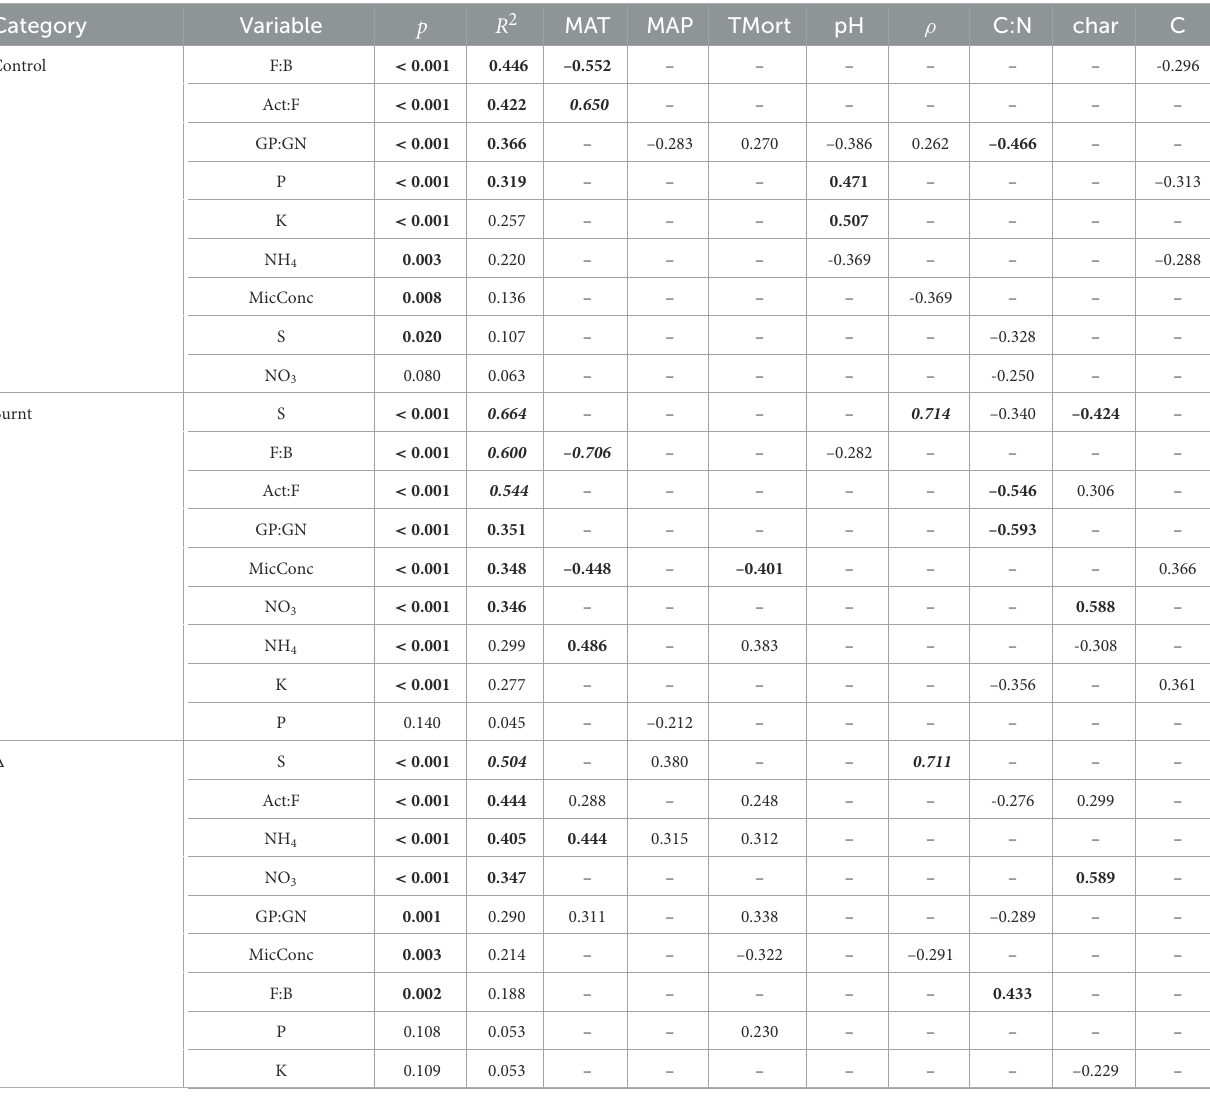
TABLE 4 Multiple regression results based on backwards step-wise model